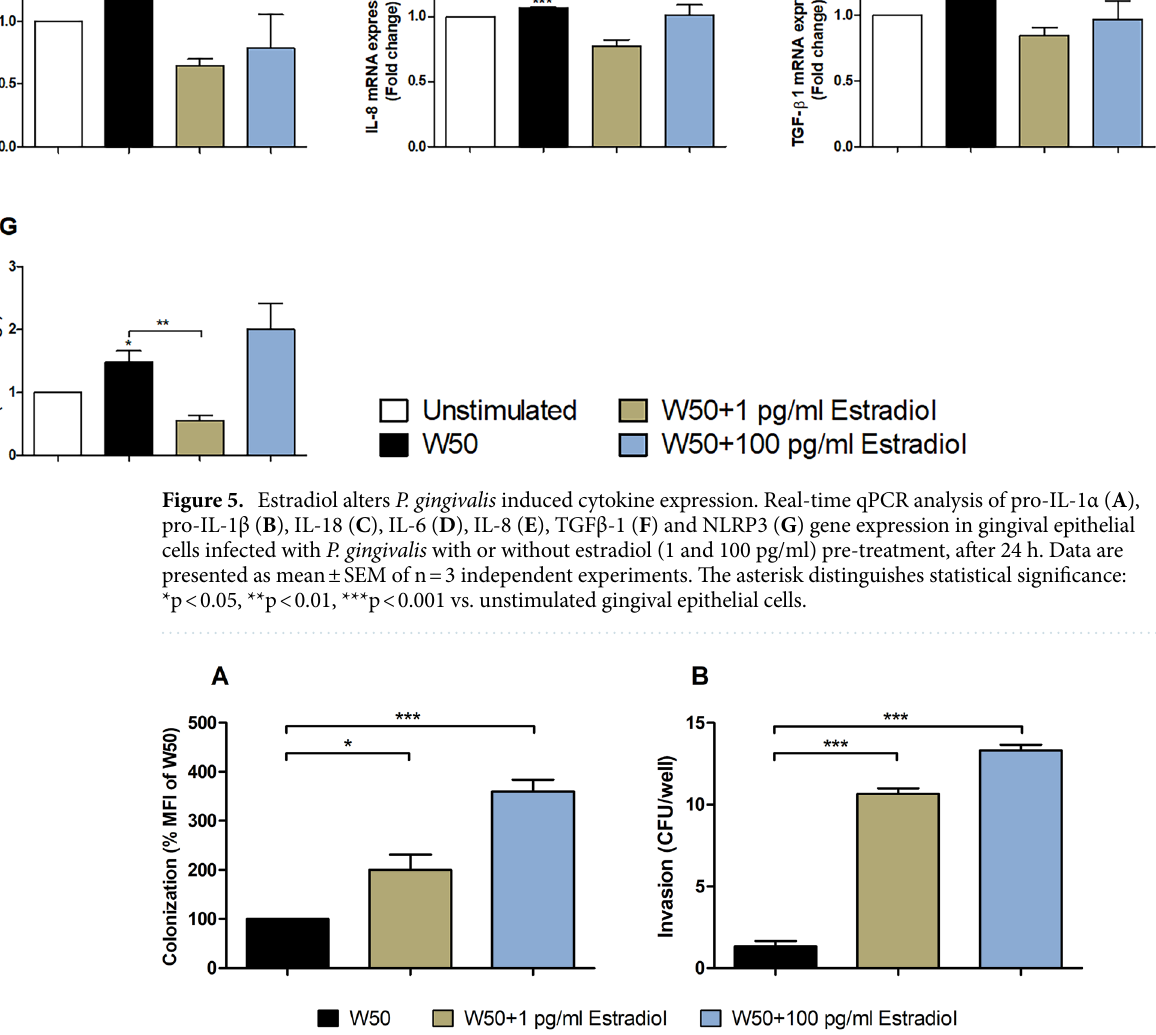
Figure 6. Estradiol mediated increased colonization and invasion. P. gingivalis W50 colonization ( A ) or invasion ( B ) of gingival epithelial cells infected with P. gingivalis with or without estradiol (1 and 100 pg/ml) pre-treatment after 2 h. Colonization quantification of FITC-labeled P. gingivalis W50 is presented as percentage mean fluorescence intensity (MFI) of W50. Invasion of gingival epithelial cells by P. gingivalis presents as CFU/ well (colony forming units). Data are presented as mean ± SEM of n = 3 independent experiments. The asterisk distinguishes statistical significance: *p < 0.05, ***p < 0.001 vs. unstimulated P. gingivalis